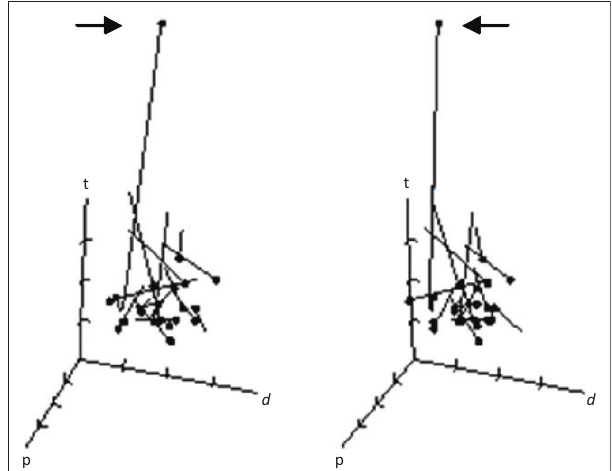
Note: Small squares represent the medians of the respective vectors, the boxes are the interquartile ranges and the ends of the whiskers are the minimum and maximum values. Each box-and-whisker plot is based on results for 20 right eyes of adults aged 19–24 years. Units for the y -axis are CIE 1976 u ’ v ’ units. CIE, International Commission on Illumination. FIGURE 2: Box-and-whisker plots for the test ( t ) and retest ( rt ) Trivector measurements for the protan ( P ), deutan ( D ) and tritan ( T ) colour